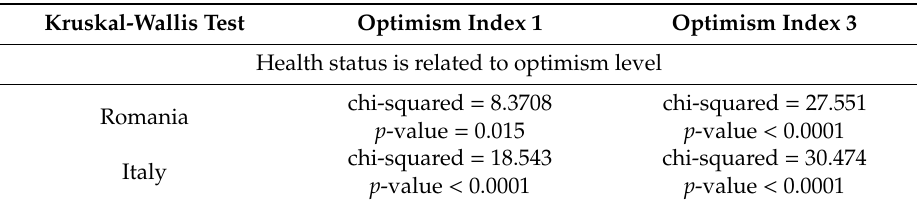
Table 7. Optimism level by health status.